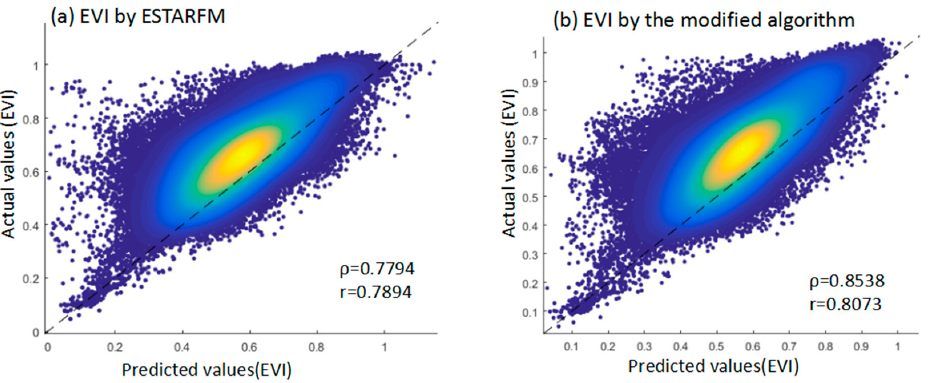
Figure 9. Scatter plots of the EVI of the actual image and prediction ones produced by ESTARFM and the modified algorithm. Table 3. Regression coefficient of the linear fitting equation, correlation coefficient, and root mean square error of EVI of predicted reflectance compared with real reflectance, for paddy rice.